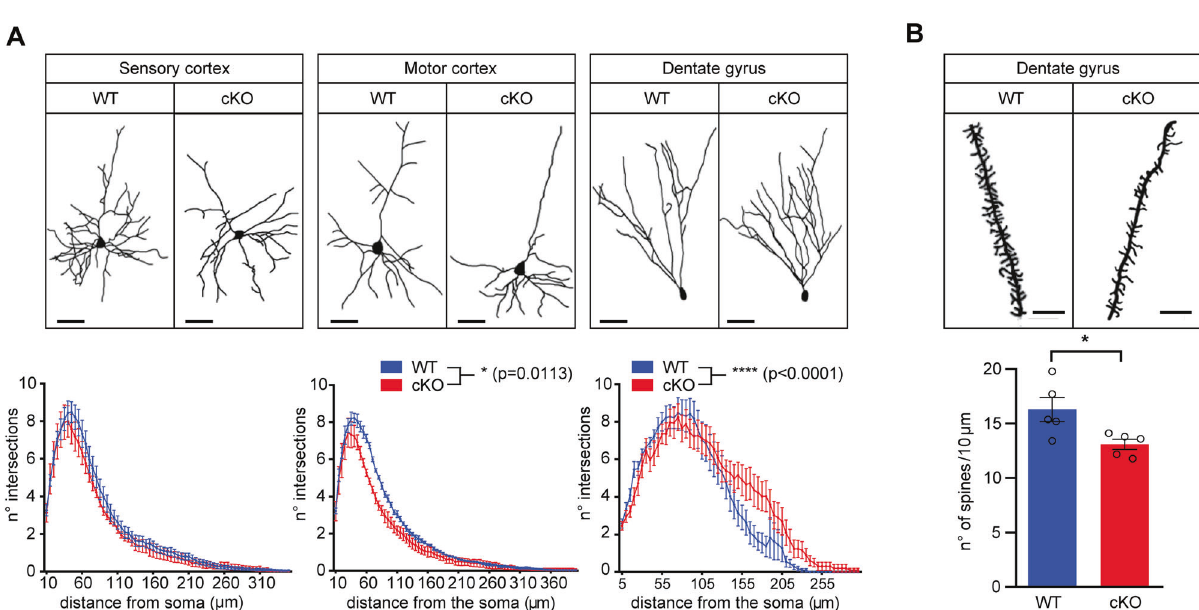
Fig. 3 Kidins220 cKO mice display altered dendritic branching in the motor cortex and dentate gyrus, and reduced spine density in the dentate gyrus of the hippocampus. A Kidins220 cKO (red) and WT (blue) animals between 2M and 3M of age were perfused, brains were dissected, and processed for Golgi-Cox staining. Upper panel: representative images; scale bar, 100 µm. Lower panel: reduced dendritic arborization was observed in the motor cortex, and increased arborization in the granule cells of the hippocampus (RM-ANOVA/Holm- Š ídák ’ s multiple comparisons test, the genotype effect is indicated. * p < 0.05; **** p < 0.0001; n = 3 animals per genotype from three separate litters. 3 – 10 cells were analysed per animal). B Brains were dissected from 3M-old cKO and WT animals and the dentate gyrus of the hippocampus was processed for Golgi-Cox staining. Upper panel: representative images; scale bar: 5 µm. Lower panel: quanti fi cation of the number of spines/10 μ m-dendrite stretch shows a signi fi cant reduction in cKO animals compared to WT. Unpaired Student ’ s t -test, * p < 0.05; n = 5 animals per genotype. At least 18 dendrites from 6 different cells per animal were analysed. Circles indicate the average number of spines for each animal). All data are expressed as means ± Neuronal density and apoptosis were analyzed by immunohisto- chemistry using anti-NeuN and anti-active caspase 3 antibodies, respectively (Fig. 2B). Neuronal density and cell survival were not affected in the cKO cortex and hippocampus, suggesting that ventricle enlargement was not due to degeneration of the surrounding structures.